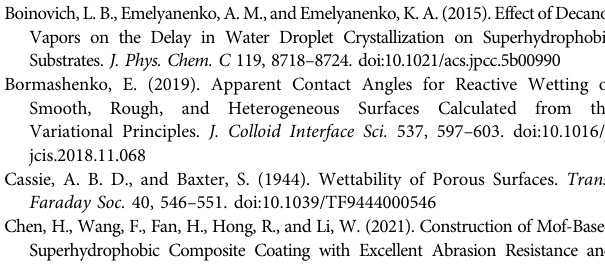
Figure 12B – E , the mechanical stability of the hand touch, hand twisting, and S-MAPOSS-F is still